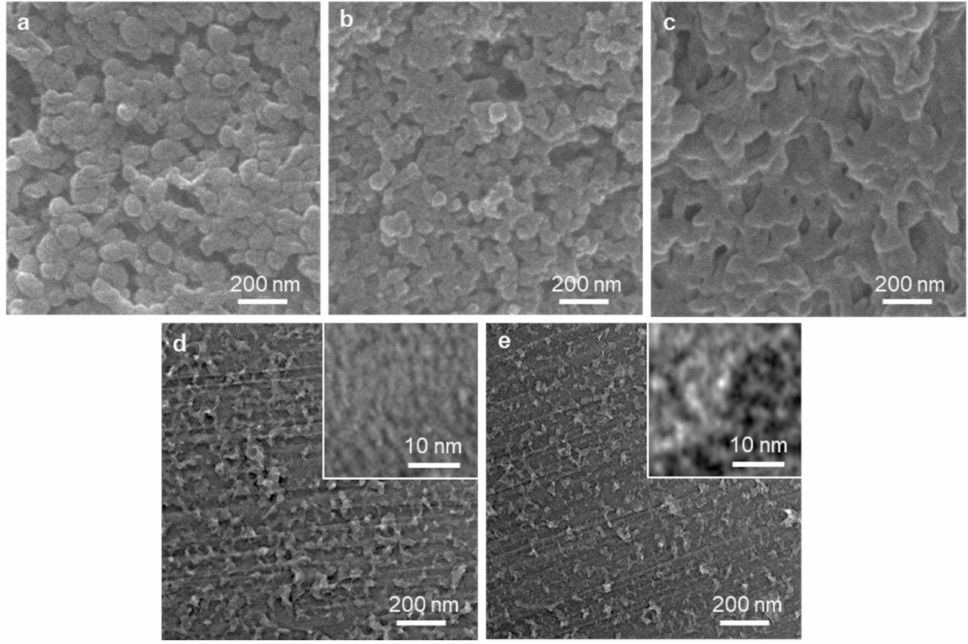
Figure 4. Structural characterization of UN, RUN340, and CRUN340. SEM images of the cross-section of ( a ) UN, ( b ) RUN340, and ( c ) CRUN340. TEM image of the cross-section of ( d ) RUN340 and ( e )